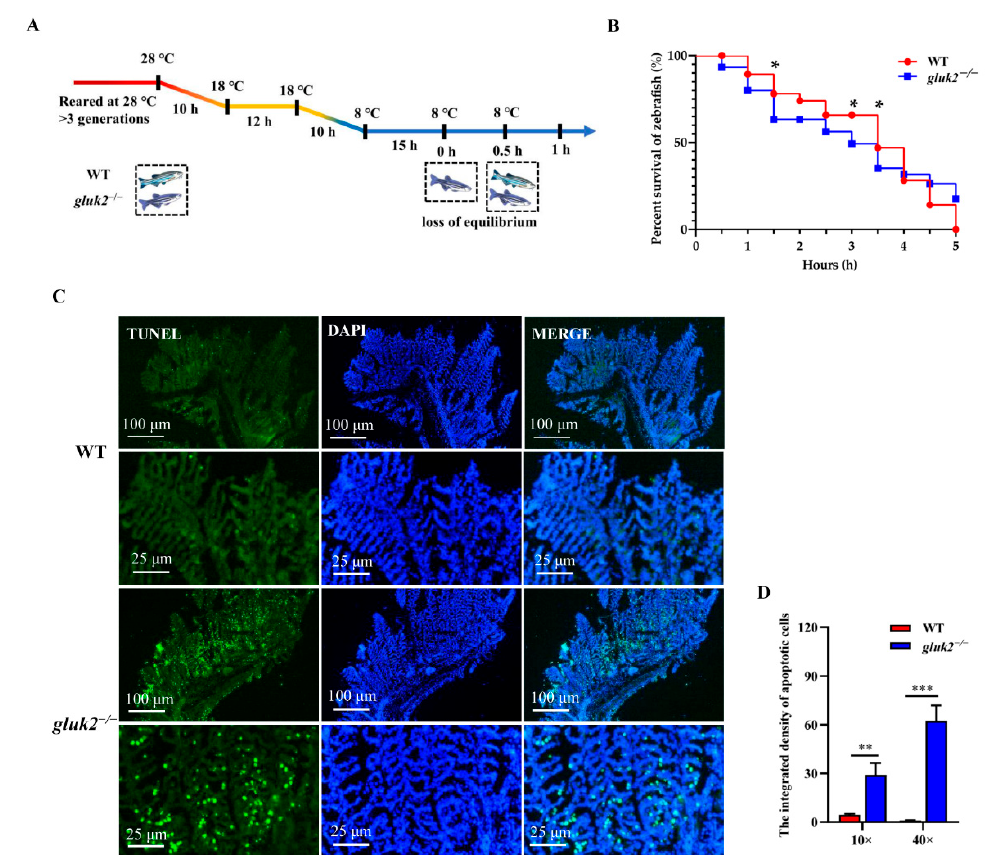
Figure 4. Distinct cold tolerance in wild-type and gluk2 − / − zebrafish under the cooling scheme. ( A ) The changes in the body equilibrium of wild-type and gluk2 − / − zebrafish over time at 8 °C. ( B ) The percent survival of wild-type and gluk2 − / − zebrafish at 8 °C from 0 h to 5 h. ( C ) TUNEL assays in the gills of wild-type and genotypes, indicating a more serious apoptosis in gluk2 − / − mutant than in wild-type at the same cold temperature. Scale bar are 100 µm and 25 µm. ( D ) Comparison of apoptotic cell populations in the gills of wild-type and gluk2 − / − zebrafish over time at 8 °C. Values plotted are means ± SEM, * p < 0.05, ** p < 0.01, *** p < 0.001, compared with control, and are based on at least three biological replicates, with each replicate having at least 3 individuals at each time point.